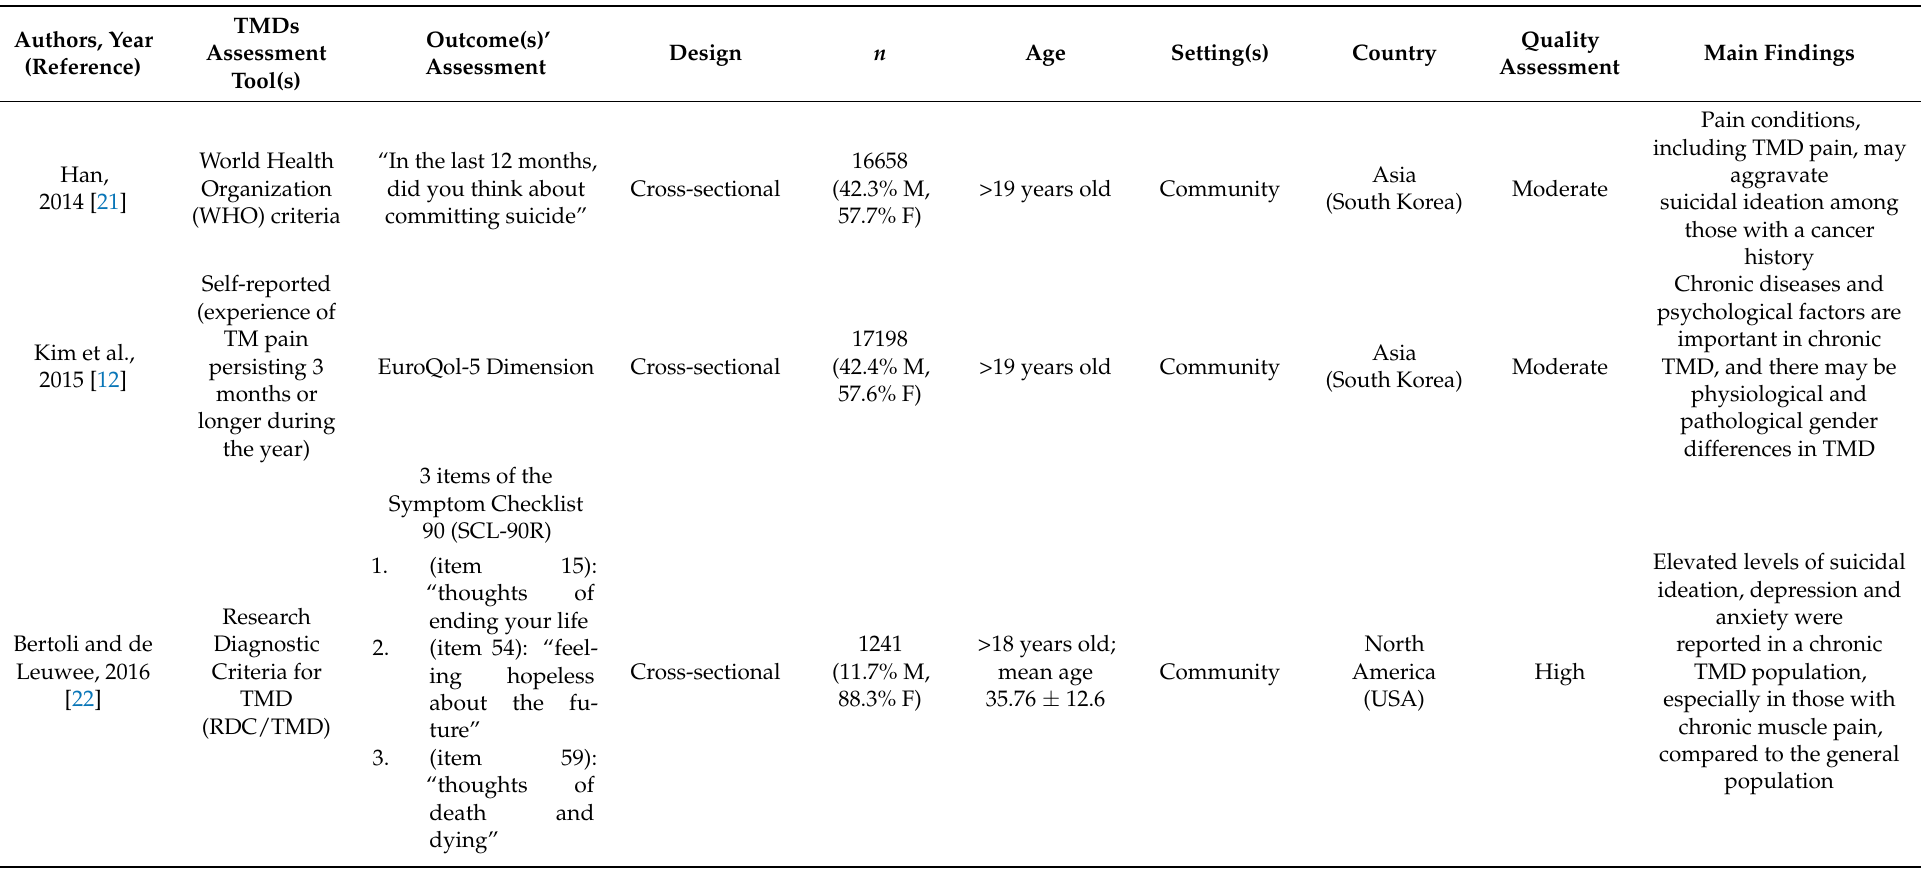
Table 1. Selected studies investigating temporomandibular disorders and suicidal behavior ( n = 6) and quality appraisal summary. M: males; F: females; TMD: temporomandibular